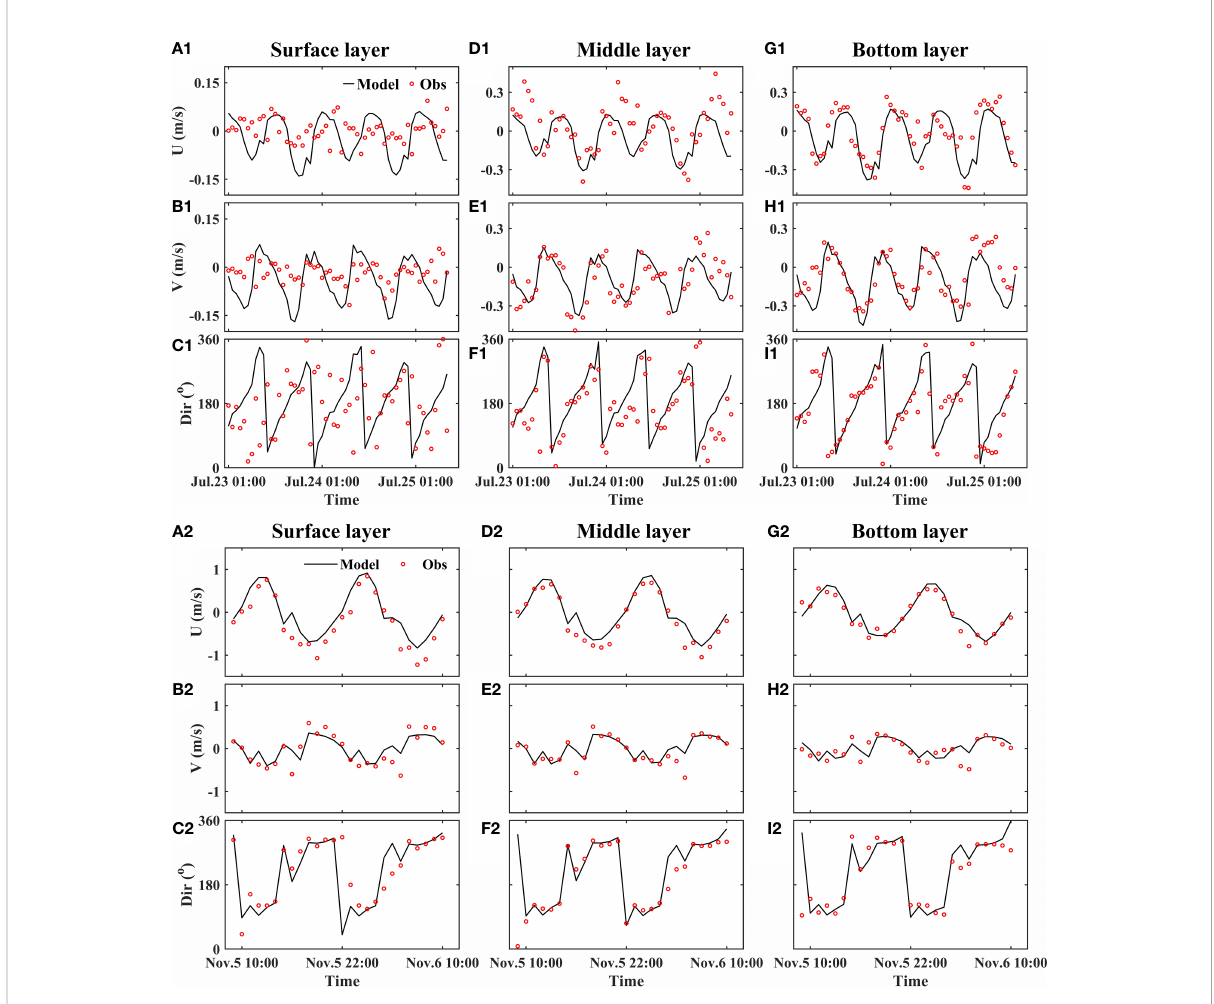
FIGURE 6 Model-data comparisons of tidal current velocity components and direction at S1 (A1-I1) inside the farm and S4 (A2-I2) outside the farm: (Upper) u in the x-direction, (Middle) v in the y-direction, (Lower) direction of current. (A – C) surface layer. (D – F) middle layer. (G – I) bottom